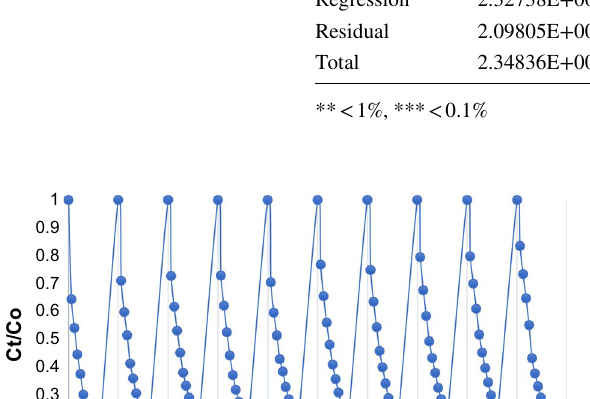
Table 5 ANOVA results for full factorial design